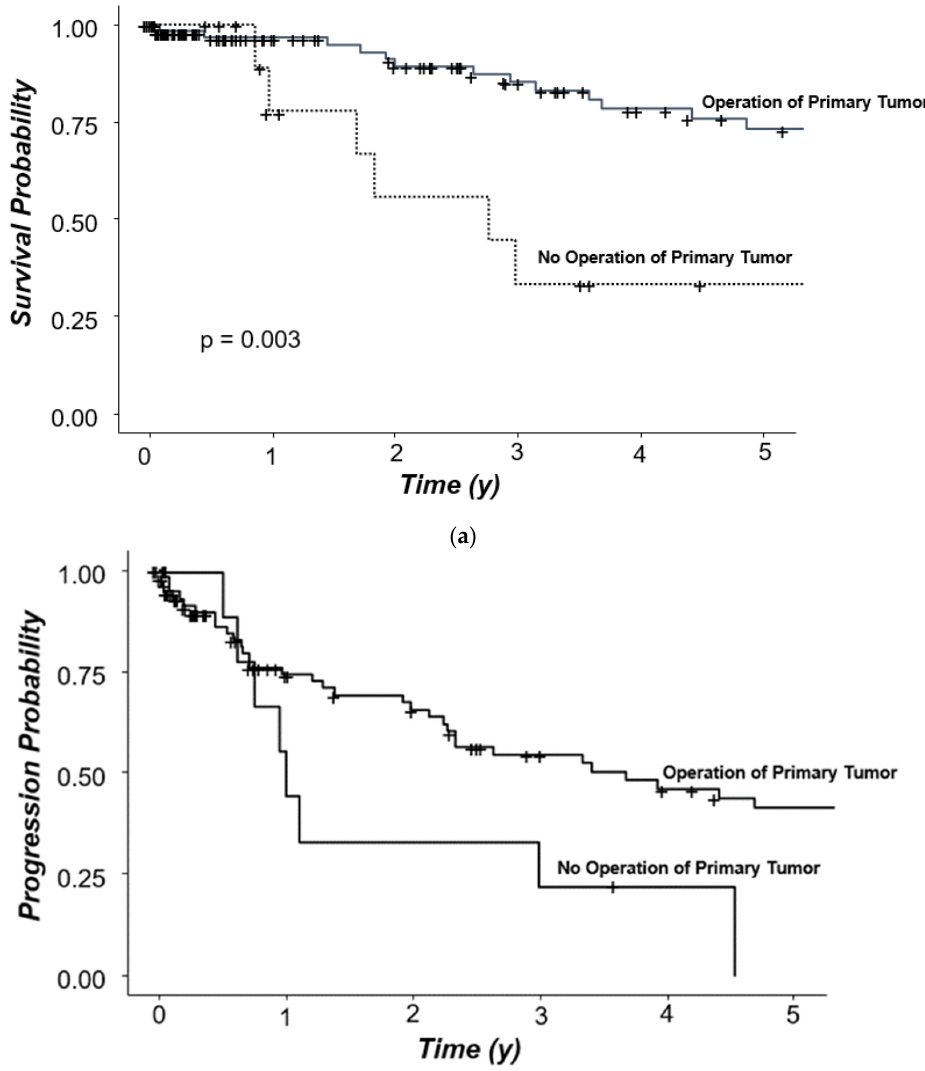
Figure 7. ( a ): Survival probability according to resection of the primary tumor, all patients. ( b ): Pro- gression probability according to resection of the primary tumor, all patients.